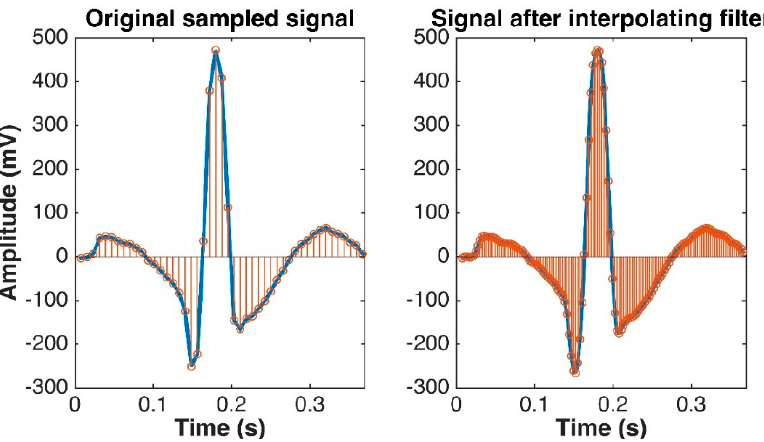
Figure 4. ECG up-sampling using cubic spline data interpolation. Left: 128 Hz; Right: 360 Hz.